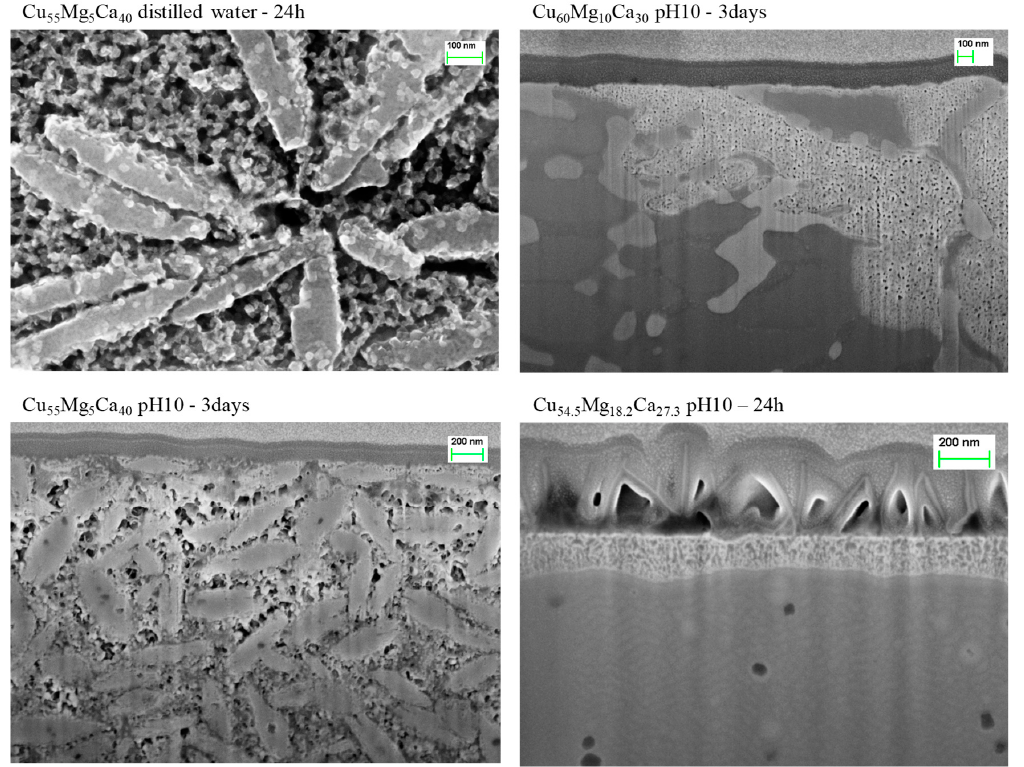
Figure 11. Selected SEM images of the surface ( left - top ) and of transversal cuts ( rest of images ) of Cu 55 Mg 5 Ca 40 , Cu 60 Mg 10 Ca 30 , Cu 54.5 Mg 18.2 Ca 27.3 dealloyed by immersion in pure water and pH = 10 solution.